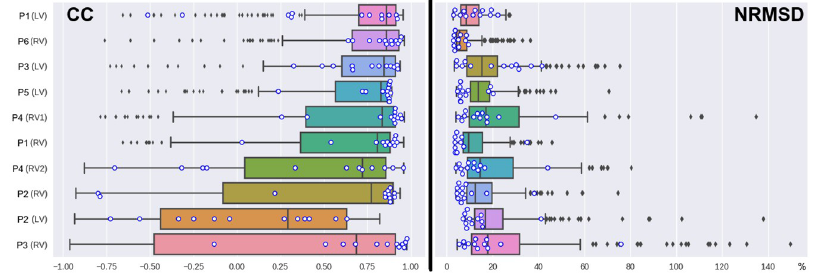
Fig 1. The distribution of correlation coefficient (CC) and NRMSD values for the simulated and measured ECGs in BSM electrodes for each patient-specific model. Patient codes (P1–P6) and paced ventricles (LV or RV) are shown in the left column. The boxes show median values and interquartile ranges. The whiskers show the minimal and maximal values without outliers (the 3-sigma rule). Outliers are shown as points outside the whiskers. Blue circles show values of the CC and NRMSD values for the 12 standard ECG